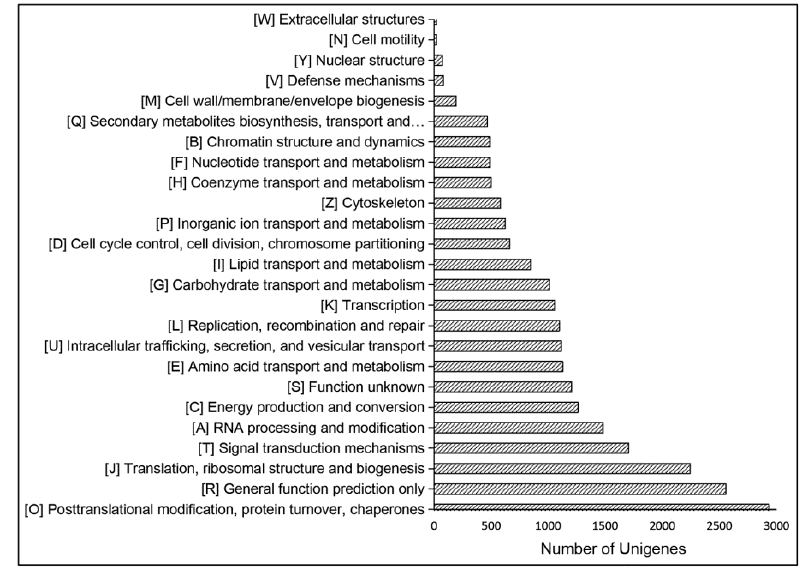
Figure 3. KOG functional classification of the unigenes. KOG: Clusters of Orthologous Groups of proteins database.